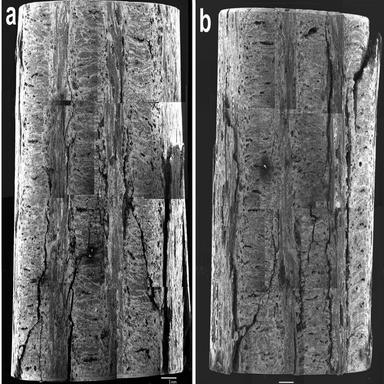
Low magnification SEM images of bottom surface of Cf-HfB2 powder composites after compressive testing along the plies. (a,b) Strongest sample (c) weakest sample.